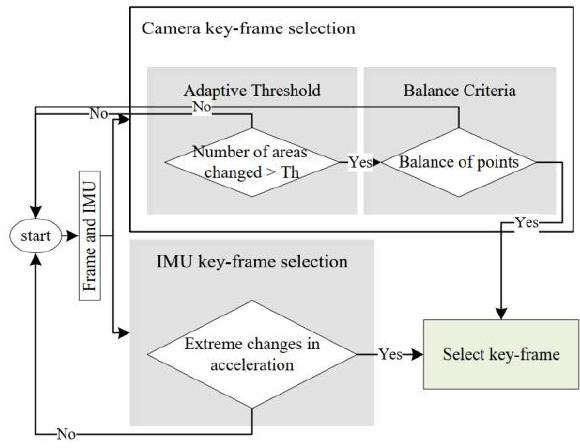
Figure 1 . The flowchart of the proposed key-frame selection